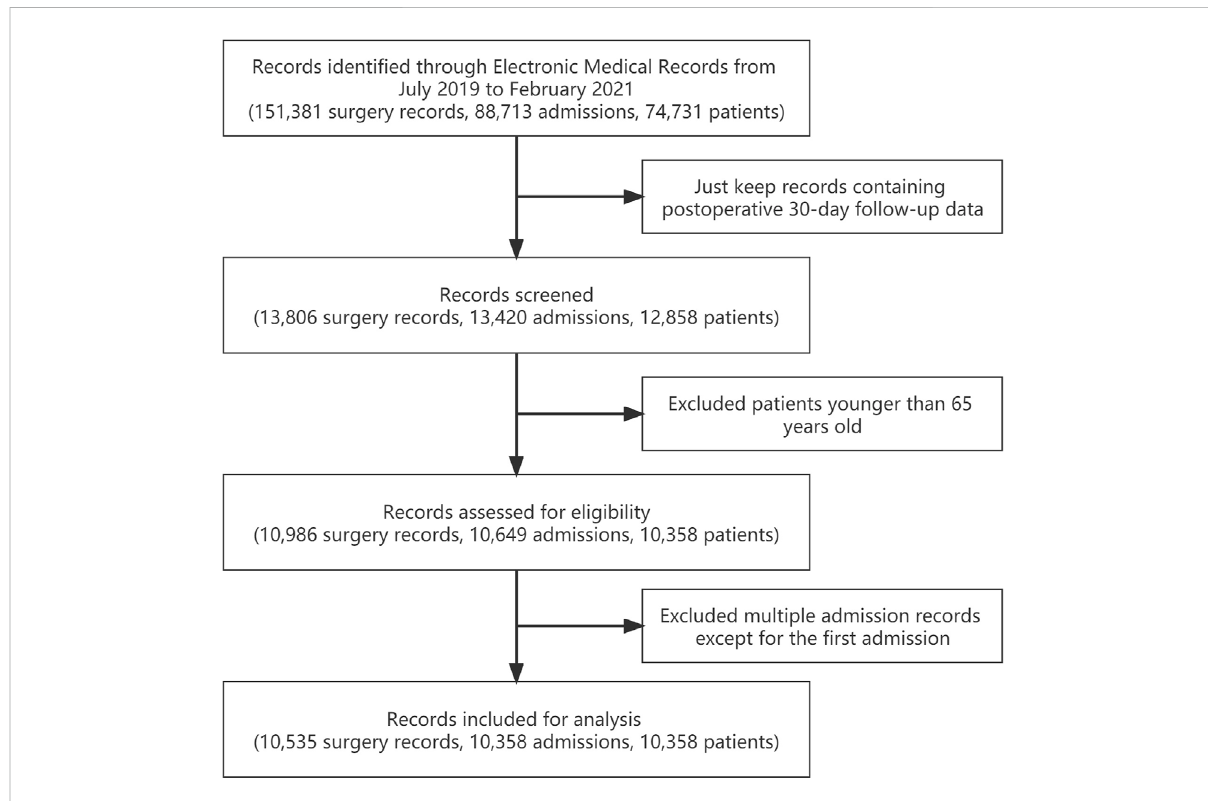
FIGURE 1 Flow chart of inclusion and exclusion process for overall data set.